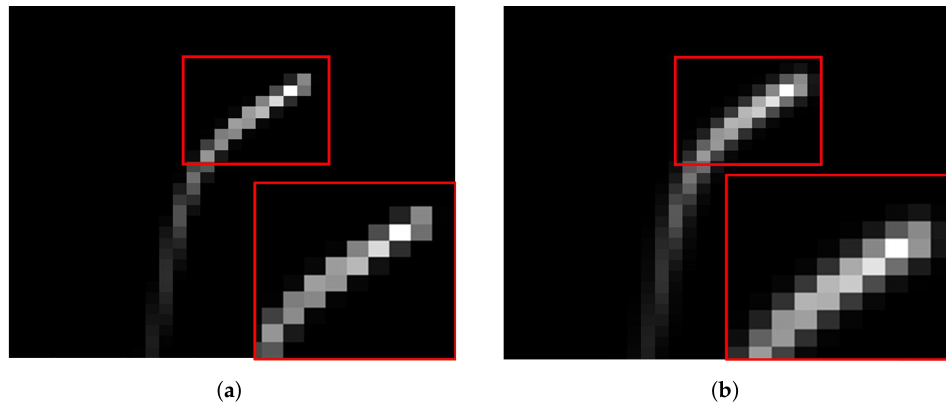
Figure 9. ( a ) Blur kernel before refinement, ( b ) blur kernel after refinement (given λ = 10 µ m, f / (cid:93) = 1.0, β =